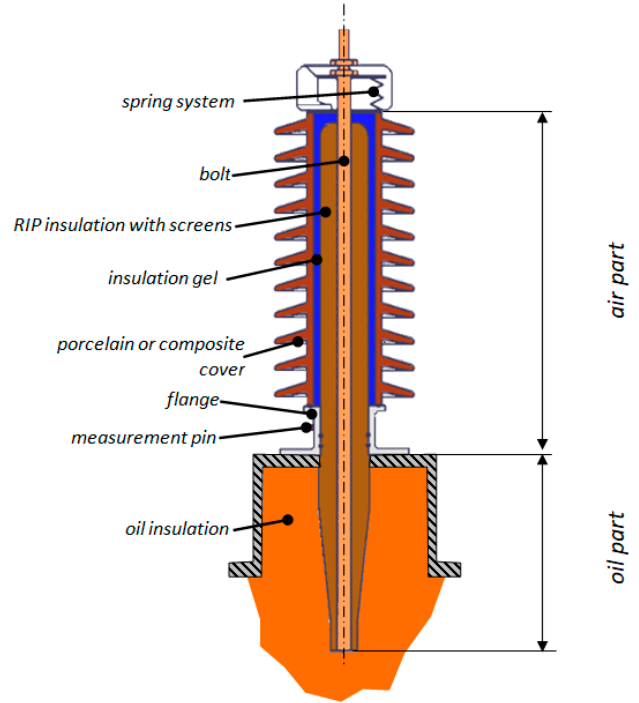
Figure 1. Cross-section of an RIP insulator.